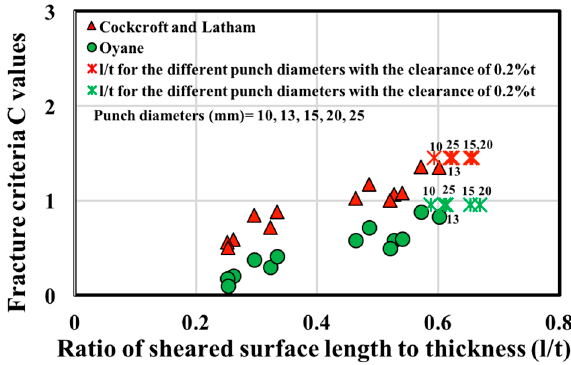
Figure 14. Relationships between the values of critical fracture criteria and ratio of sheared surface length to thickness predicted by the punch diameters of 10, 13, 15, 20, and 25 mm for the clearance of 0.2 %t.